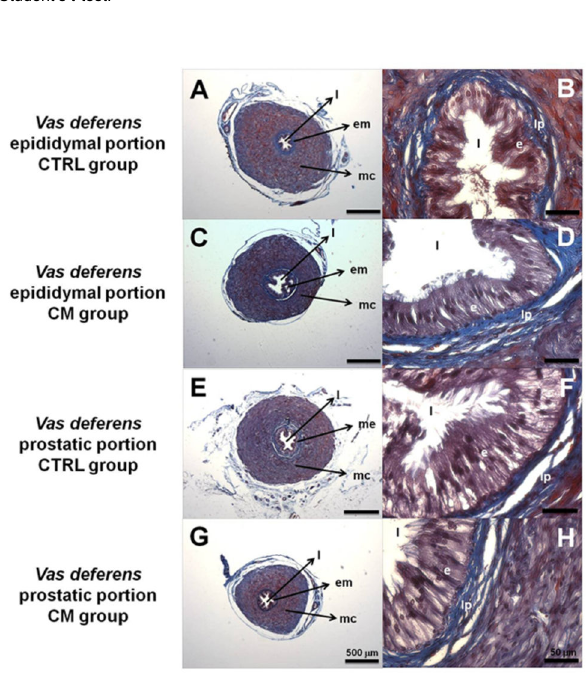
Figure 2. Germ cell counts in testis, epididymis and vas deferens . Total (A) and haploid (B) cells were counted in testis, epididymis and vas deferens from different CTRL (n = 10) and CM (n = 7) rats. (C) Percentage of DNA-fragmented cells in the total cell populations of the three organs. Results are mean ± SEM. *P<0.05 vs. the respective CTRL; # P<0.05 vs. cell counts in epididymis of CM rats (unpaired Student’s t - test).